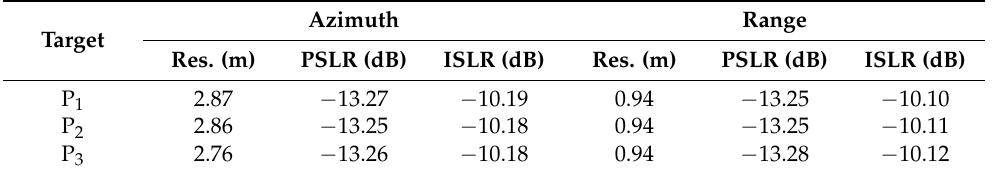
Figure 17. Imaging results on three point-targets handled by the proposed method. ( a ) Imaging results with three points; ( b ) contour plot of target P 1 ; ( c ) contour plot of target P 2 ; ( d ) contour plot of target P 3 . Table 2. Performance indicators of three point-targets of the proposed